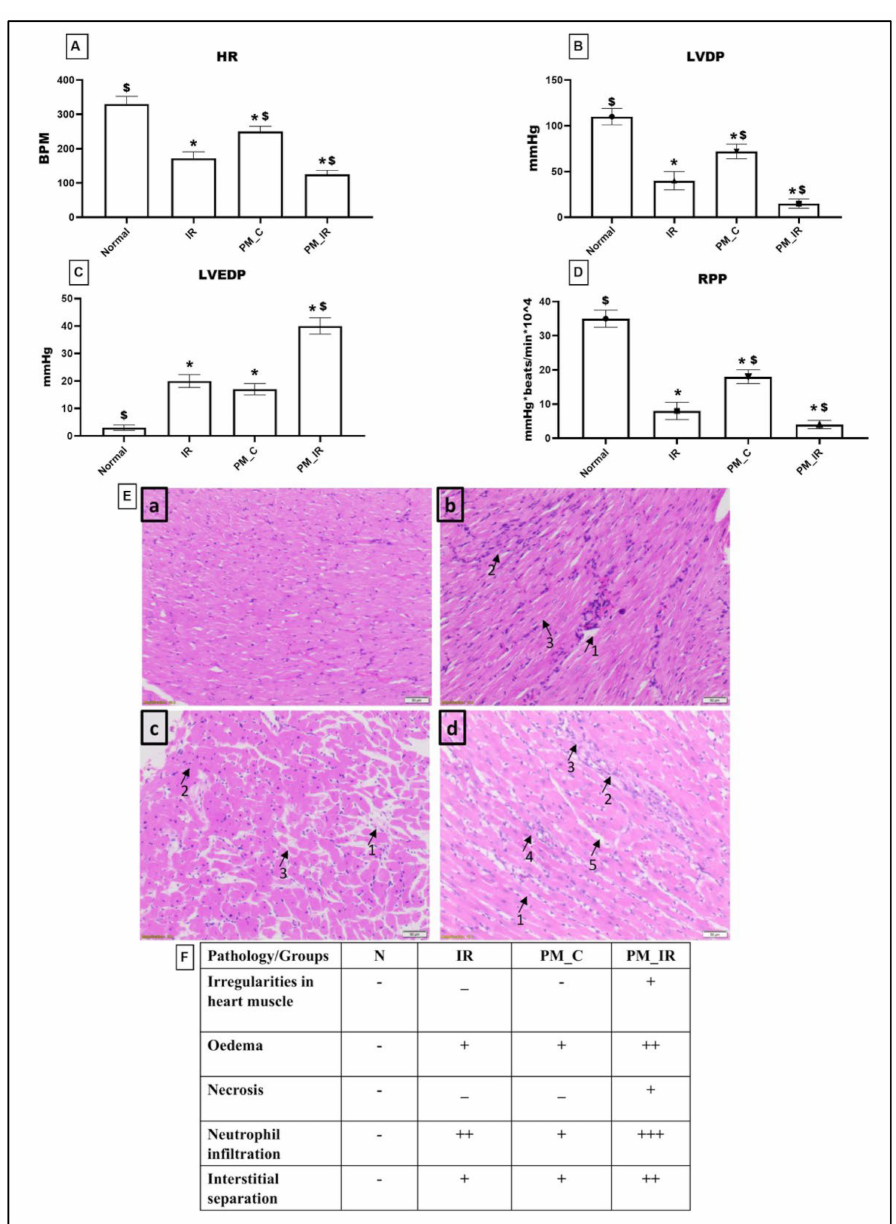
Figure 2. Analysis of cardiac hemodynamic parameters. ( A ) Heart rate (HR). ( B ) Left ventricular developed pressure (LVDP). ( C ) Left ventricular end-diastolic pressure (LVEDP). ( D ) Rate pressure product (RPP). (* p < 0.05 vs. normal, $ p < 0.05 vs. IR control). Values are mean ± SD ( n = 6 per group).